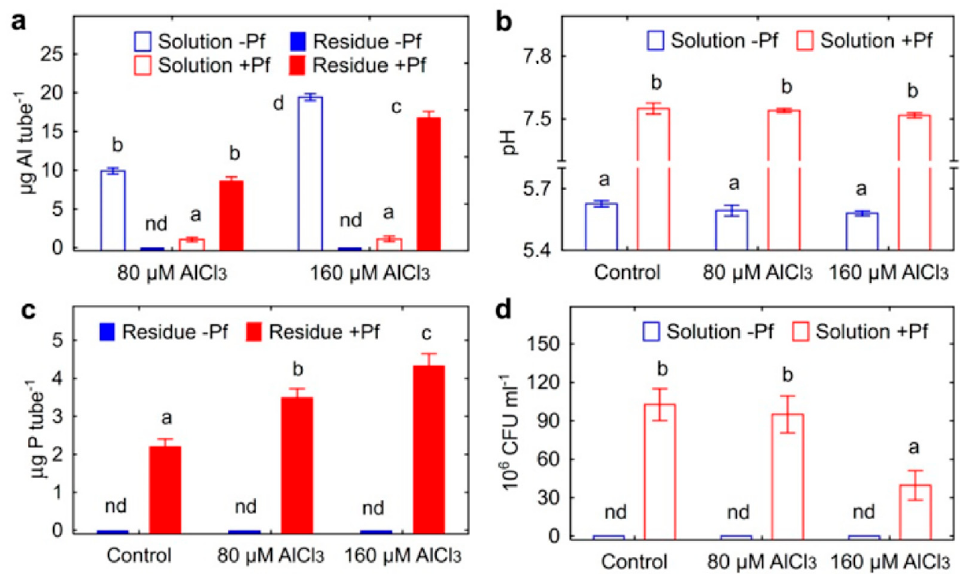
Figure 1. The amount of aluminum in solution and residue ( a ), pH of the solution ( b ), the amount of P ( c ) and the number of bacteria ( d ) in batch culture of Ps. fluorescens SPB2137 supplemented with 80 or 160 µ M AlCl 3 . Treatments: − Pf—sterile control, +Pf—inoculated with Pseudomonas fluorescens SPB2137. Vertical bars show standard errors. Different letters show significant differences between treatments (least significant difference test, p < 0.05, n = 3). CFU stands for colony-forming units.